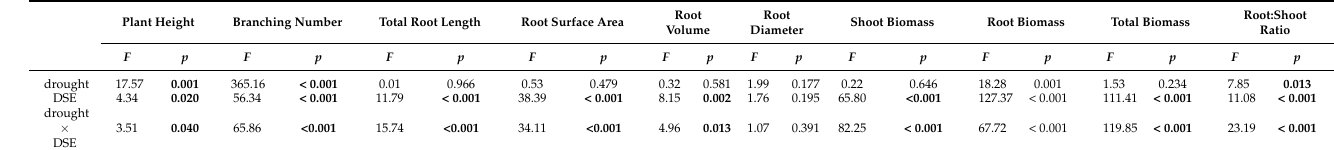
Table 1. Analysis of variance for the effects of drought stress and dark septate endophyte (DSE) inoculation on the shoot and root morphological traits and biomass production of Artemisia ordosica seedlings.